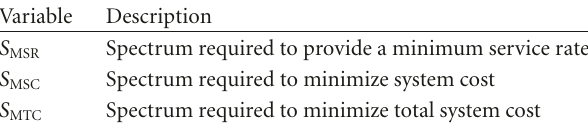
Table 2: Output spectrum requirements.